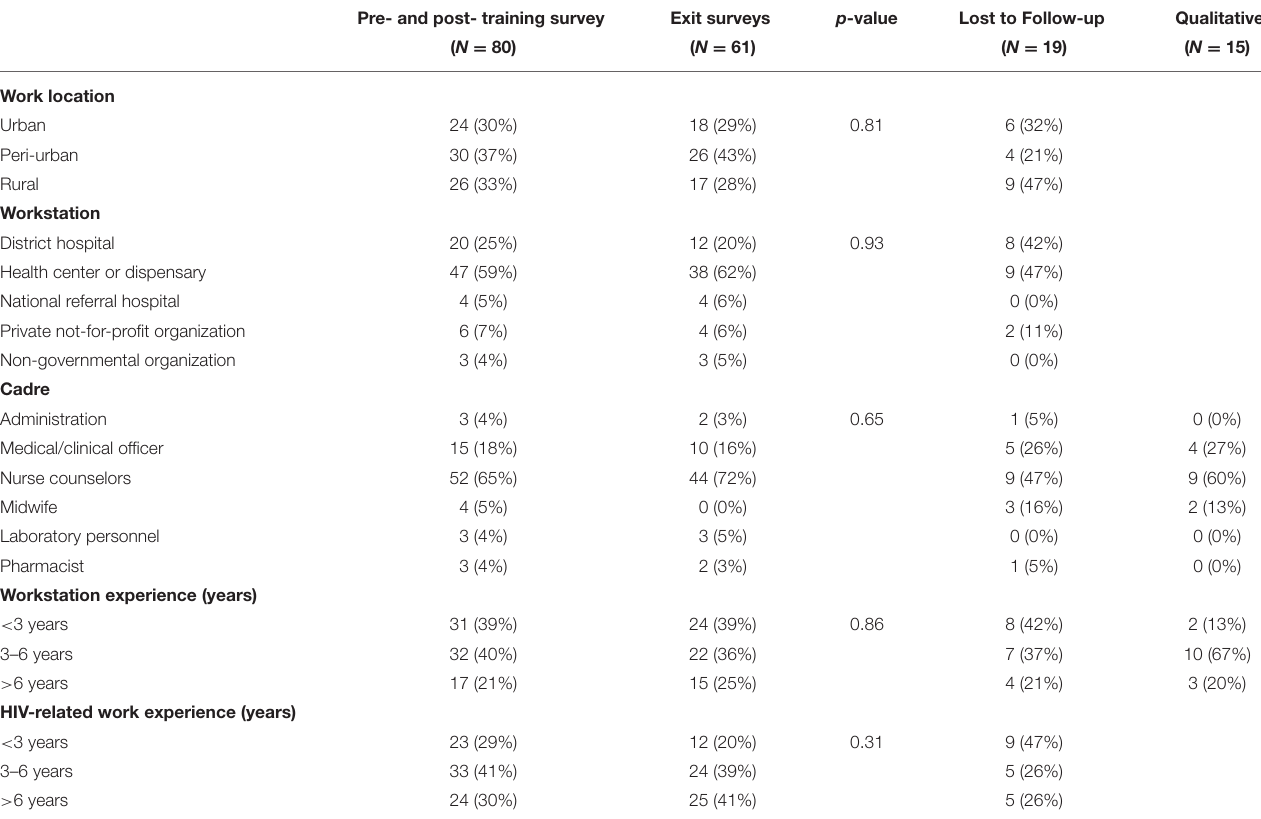
TABLE 1 | Participant